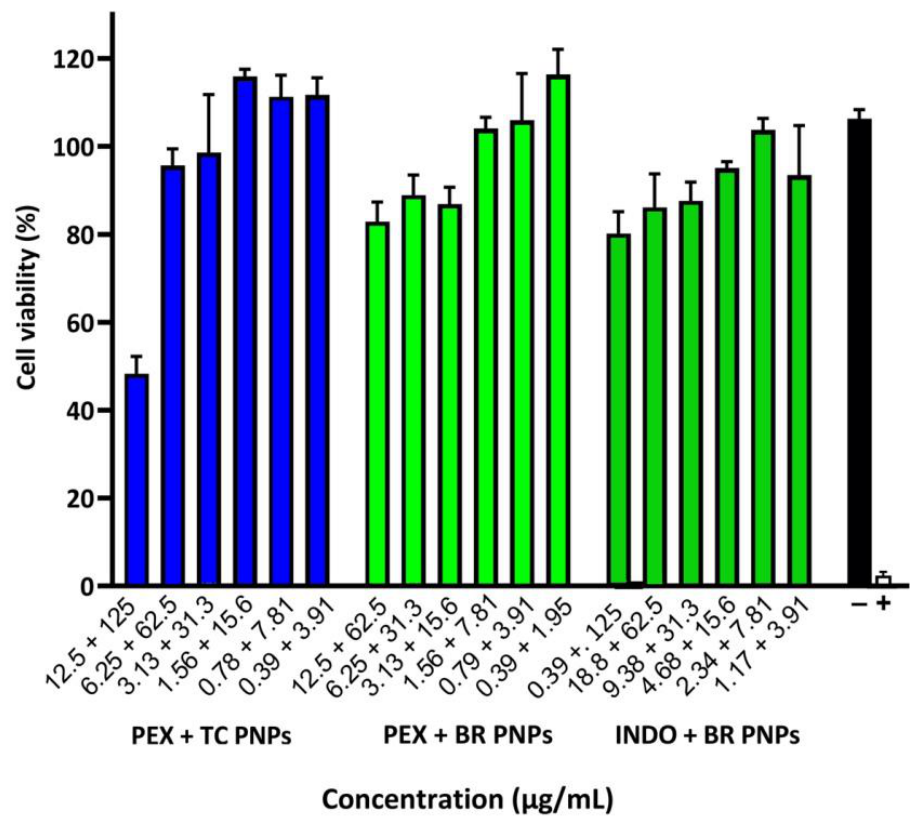
Figure 6. Resazurin cell viability assay for HEK-293 cells in the presence of PEX/TC, PEX/BR or INDO/BR PNP combinations at 24 h. The data are expressed as the mean percent cell viability ± SD ( n = 3). The positive control (+) consisted for 10% ( v / v ) SDS, 0.1 M HCl, while the negative control ( − ) consisted of cells treated with complete media containing 0.01% ( v / v ) DMSO.